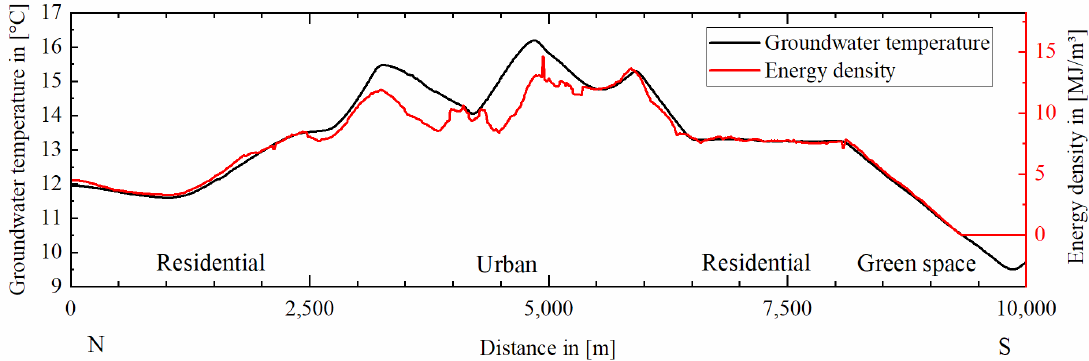
Figure 7. Cross-section in the N-S direction through the Nuremberg working area. The extracted data show the groundwater temperature of the SUHI and the energy density of the e-SUHI.